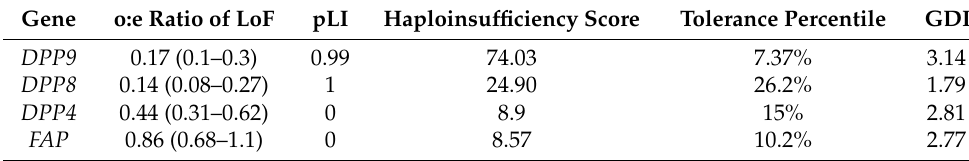
Table 6. Genetic variation tolerance in the DPP4 gene family. The o:e ratio, pLI and haploinsufficiency score were retrieved from gnomAD and DECIPHER. Tolerance percentile and GDI values were retrieved from the GeneCards human gene database. o:e, the observed to expected ratio. pLI, the probability of LoF intolerance. GDI, gene damage index